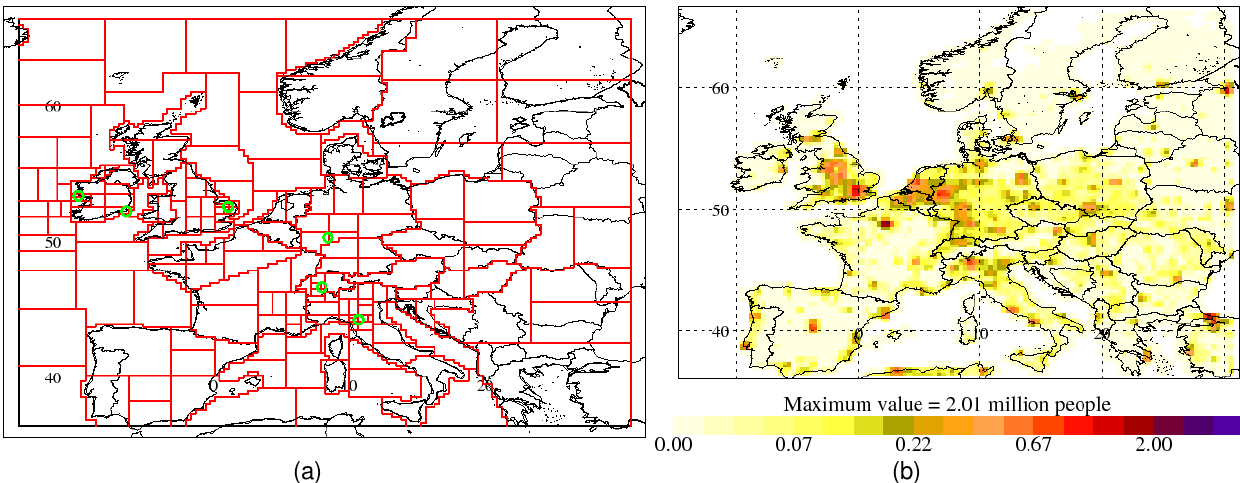
Figure 1. (a) Example grid structure used in InTEM. Green circles denote the locations of the measurement stations. (b) Population per 25km grid box in units 10 6